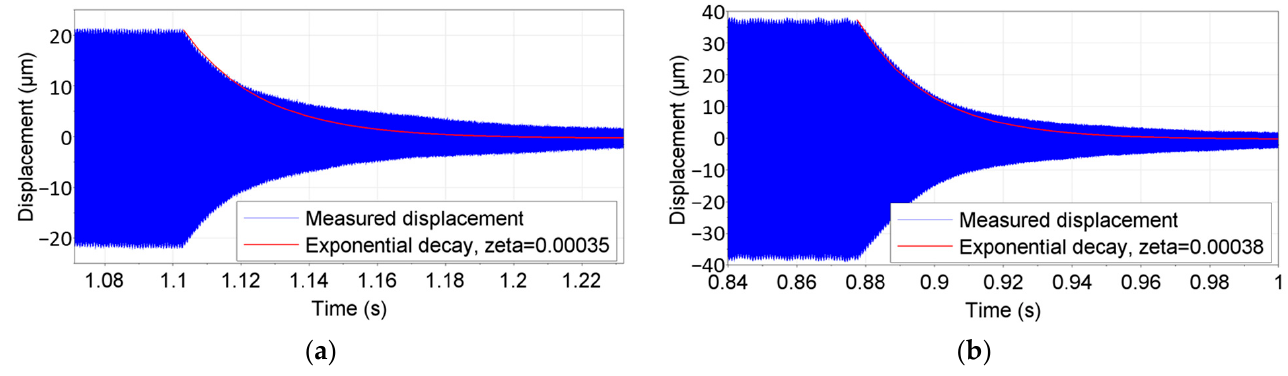
Figure 13. 51CrV4 steel, UHCF specimen, exponential decay: ( a ) Maximum stress = 400 MPa; ( b ) Maximum stress = 600 MPa.